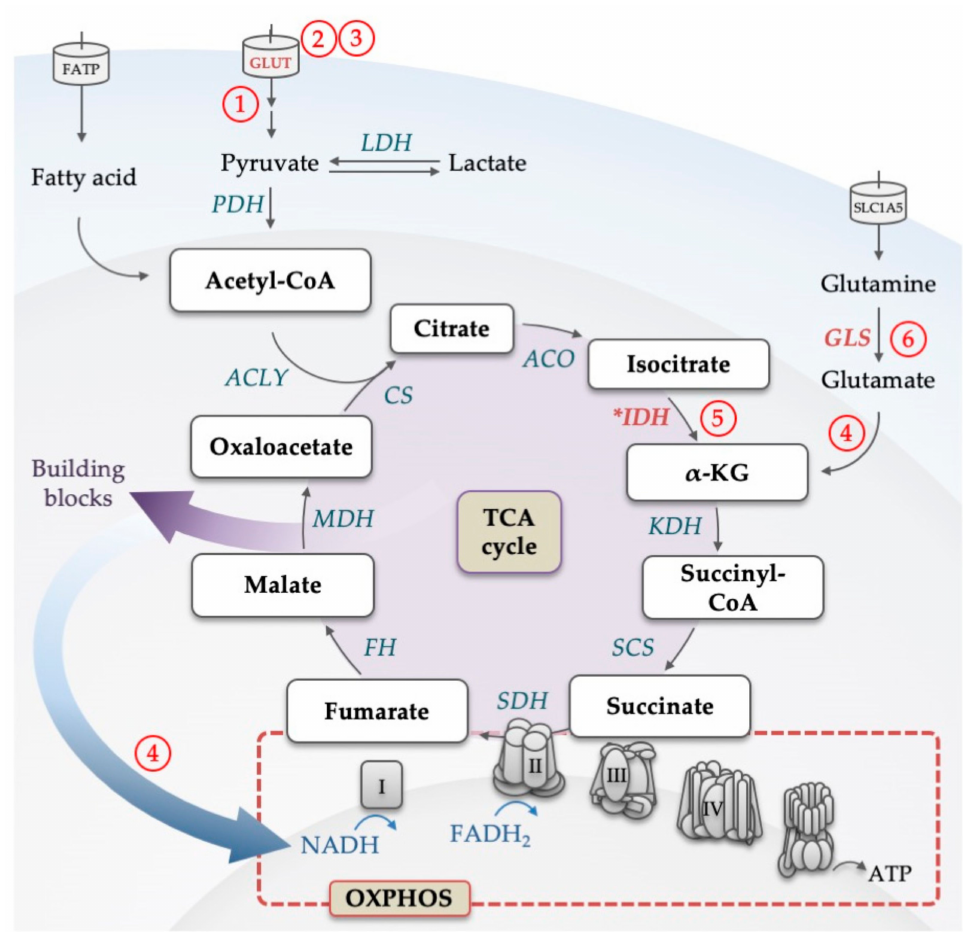
Figure 3. Illustration of the backbone of the tricarboxylic acid (TCA) cycle. Glucose-derived pyruvate and fatty acids are converted to acetyl-CoA, which feeds the TCA cycle. For each glucose molecule metabolized into the cycle, six NADH, two FADH 2 and two ATP (or two GTP) are being produced. Through the conversion to α -KG, also glutamine can replenish the TCA cycle. Products of the cycle are then utilized in the electron transport chain to produce ATP by the oxidative phosphorylation process. Electrons from NADH and FADH 2 flow through complexes I, II, III, and IV, which results in a proton gradient across the inner mitochondrial membrane. This in turn provides the energy required to drive ATP synthesis via ATP synthase. Intermediates of the TCA cycle are used as building blocks in other metabolic pathways. Enzymes that are dysregulated in AML are marked in red, mutated are marked with an asterisk. Abbreviations: α -KG, alpha ketoglutarate; ACLY, adenosine triphosphate citrate lyase; ACO, aconitase; ATP, adenosine triphosphate; CoA, coenzyme A; CS, citrate synthase; FADH 2 , reduced flavin adenine dinucleotide; FATP, fatty acid transporter; FH, fumarate hydratase; GLUT, glucose transporter; GLS, glutaminase; IDH, isocitrate dehydrogenase; KDH, α -KG dehydrogenase; LDH, lactate dehydrogenase; MDH, malate dehydrogenase; NADH, nicotinamide adenine dinucleotide; OXPHOS, oxidative phosphorylation; PDH, pyruvate dehydrogenase; SCS, succinyl-CoA synthase; SDH, succinate dehydrogenase; SLC, solute carrier family; TCA, tricarboxylic acid. Circled